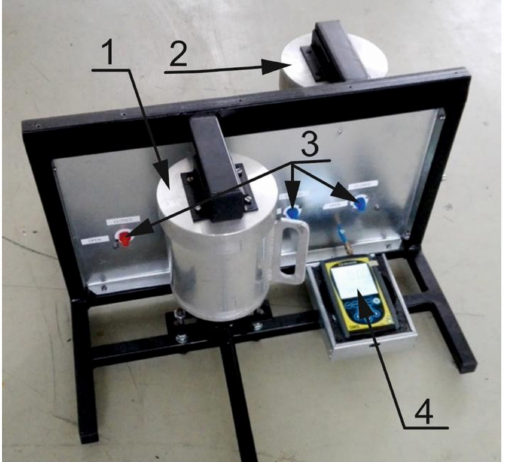
Figure 3. Assembly of the apparatus for measuring the volume of particulate solids (wood chip porosity). ( 1 )—sample cylinder, ( 2 )—reference cylinder, ( 3 )—air valves, ( 4 )—Cressto DMS 1 pres- sure